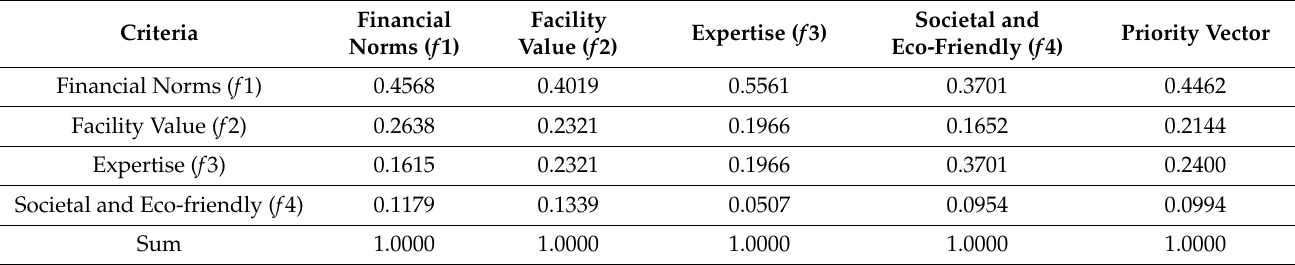
Table 10. Normalised judgment